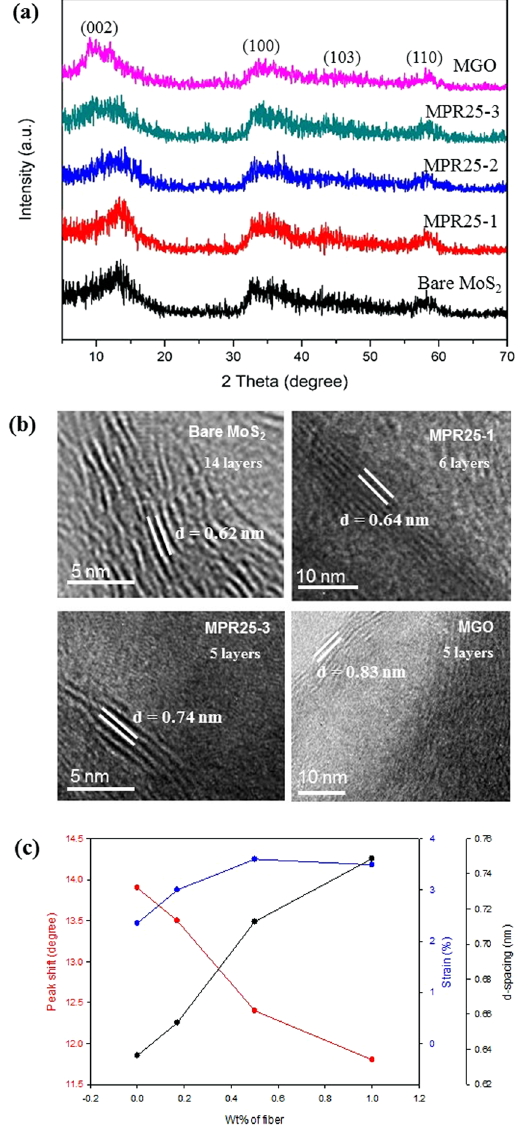
Figure 2. ( a ) XRD diffraction patterns, ( b ) HR-TEM images of bare MoS 2 and its composites and their d-spacing and no. of layer, and ( c ) effect of the wt% of fiber to the peak shift, strain, and